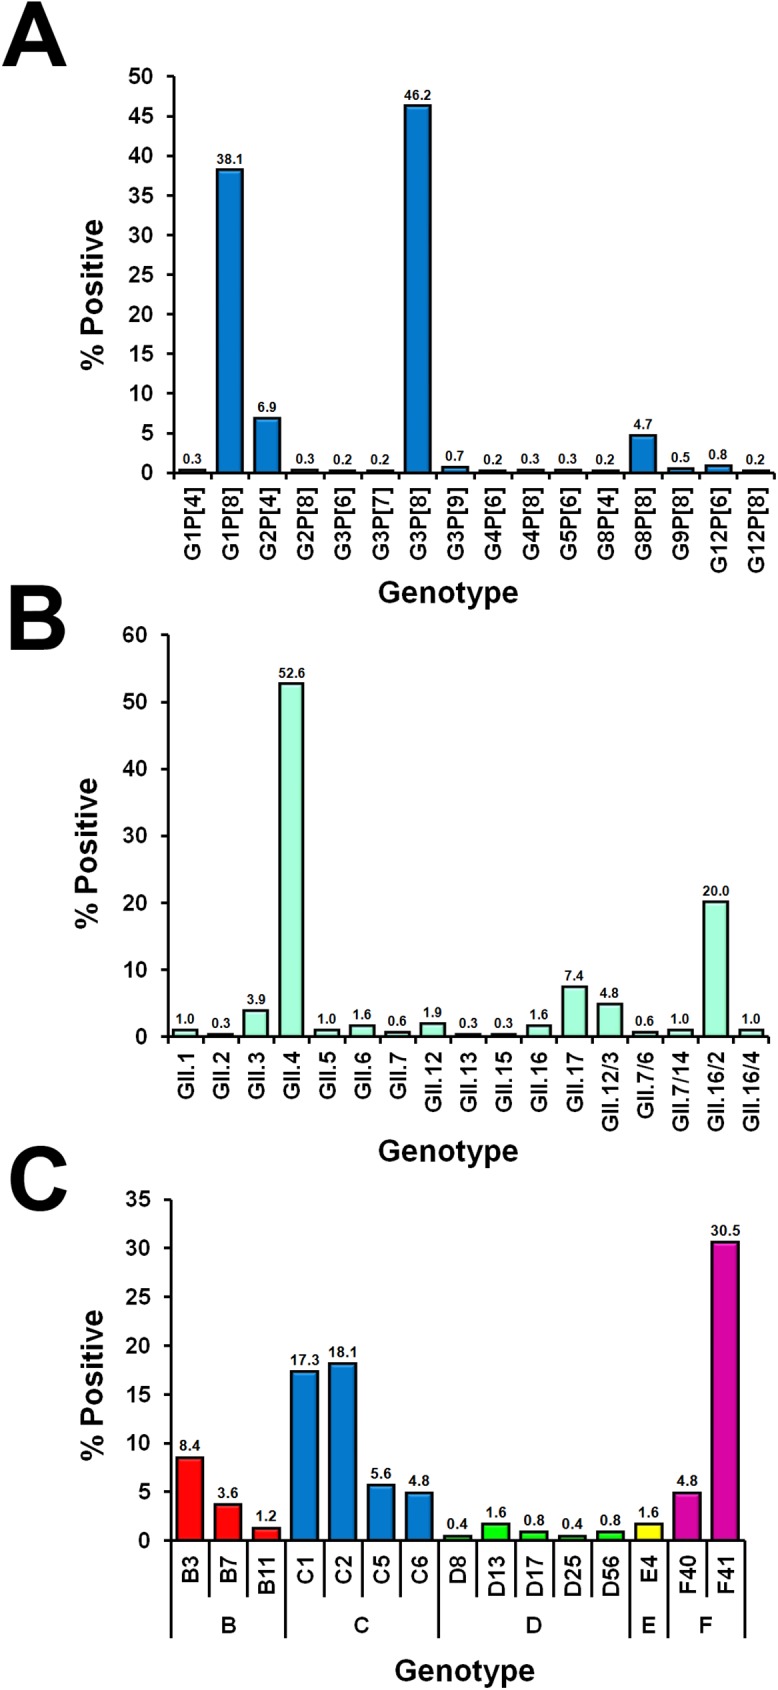
AGE samples tested positive for diverse genotypes of RV, NV, and ADV.The genotype distribution of (A) RV based on the VP7 and VP4 genes, (B) NV based on the RdRp/VP1 region, and (C) ADV based on the hexon gene.